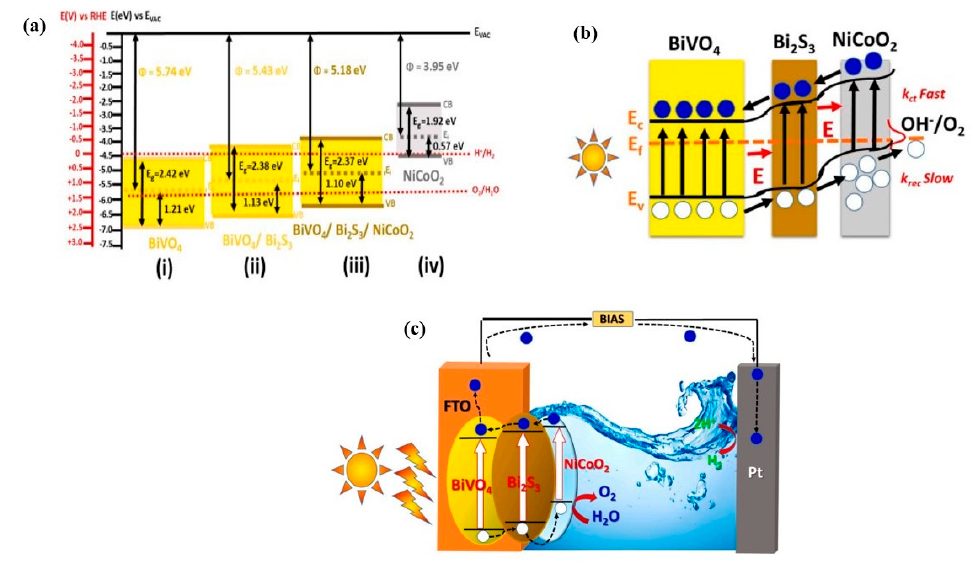
Figure 9. ( a ) Estimation of the band alignment calculated from UPS analysis with regard to vacuum and converted to E (V) vs. RHE, whereas ( b ) shows the schematic of n–n–p junction ladder in the staggered band structure of BiVO 4 /Bi 2 S 3 /NiCoO 2 photoanode. The terms k rec and k ct refer to the surface recombination and charge transfer through surface states, respectively, and ( c ) shows the schematic of the water oxidation of BiVO 4 /Bi 2 S 3 /NiCoO 2 photoanode. [Reprinted with permission from reference [129]. Copyright 2022,